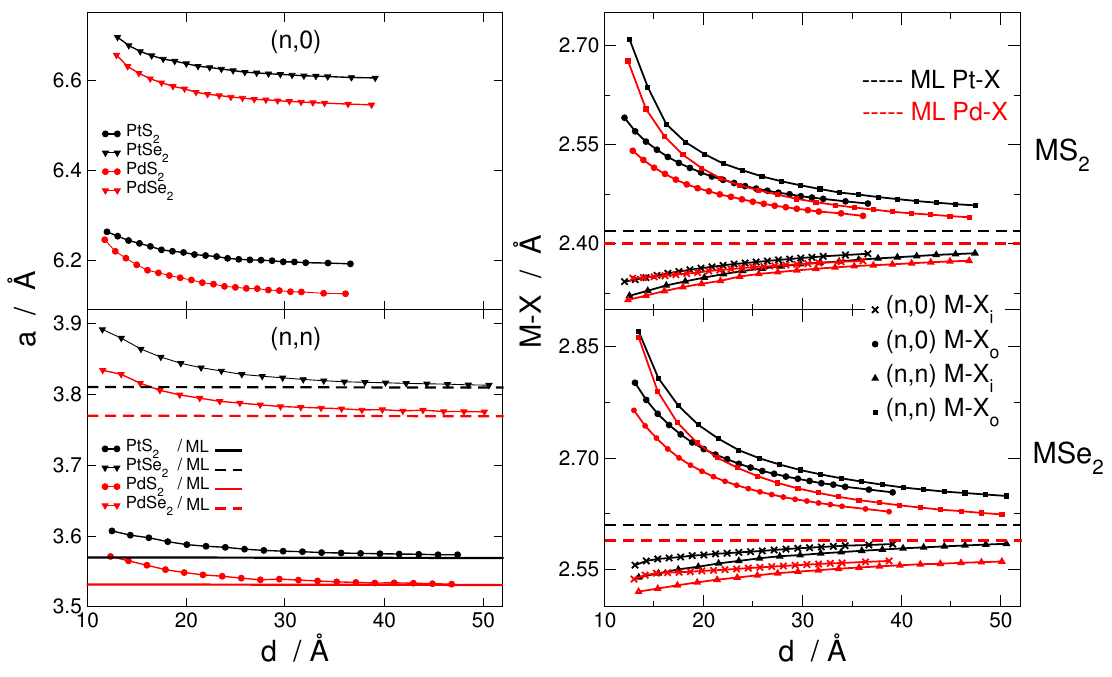
Figure 2. Lattice parameters and bond lengths vs. diameter of MX